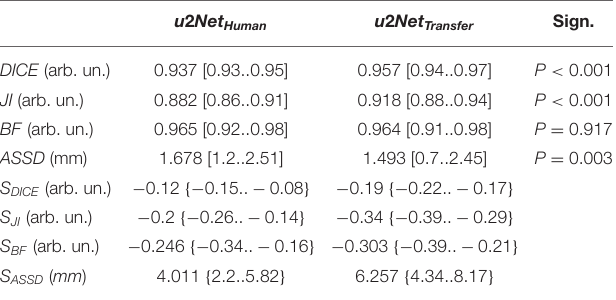
TABLE 3 | Segmentation quality metrics for the two networks trained on human data only u 2 Net Human and on both experimental and clinical data sequentially u 2 Net Transfer . u 2 Net Human u 2 Net Transfer Sign.